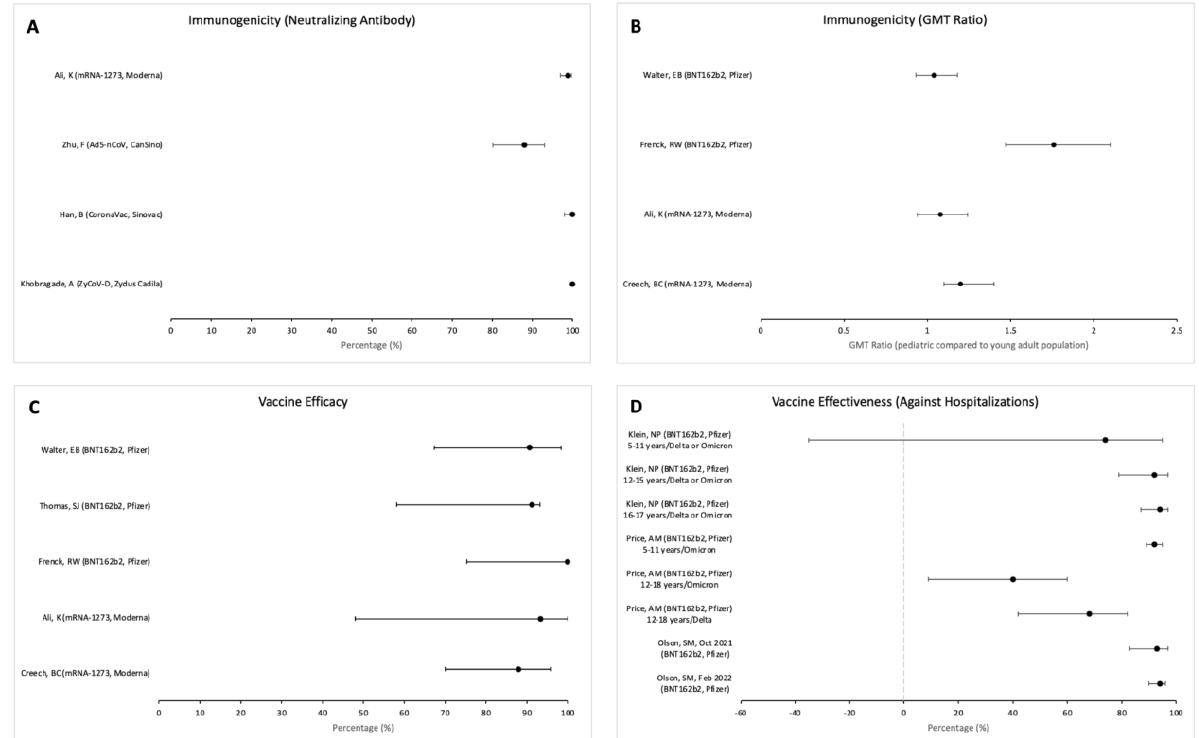
Figure 2. Forest plots describing ( A ) percent of the paediatric study population showing serocon- version of neutralising antibodies after the primary COVID-19 vaccine series [25,26,29,32], ( B ) geo- metric mean titre (GMT) ratio of paediatric study population compared with young adult popula- tion [24,26,31,33], ( C ) vaccine efficacy in paediatric COVID-19 vaccine clinical trials [24,26,27,31,33], and ( D ) vaccine effectiveness against COVID-19-related hospitalizations [35,40,41].